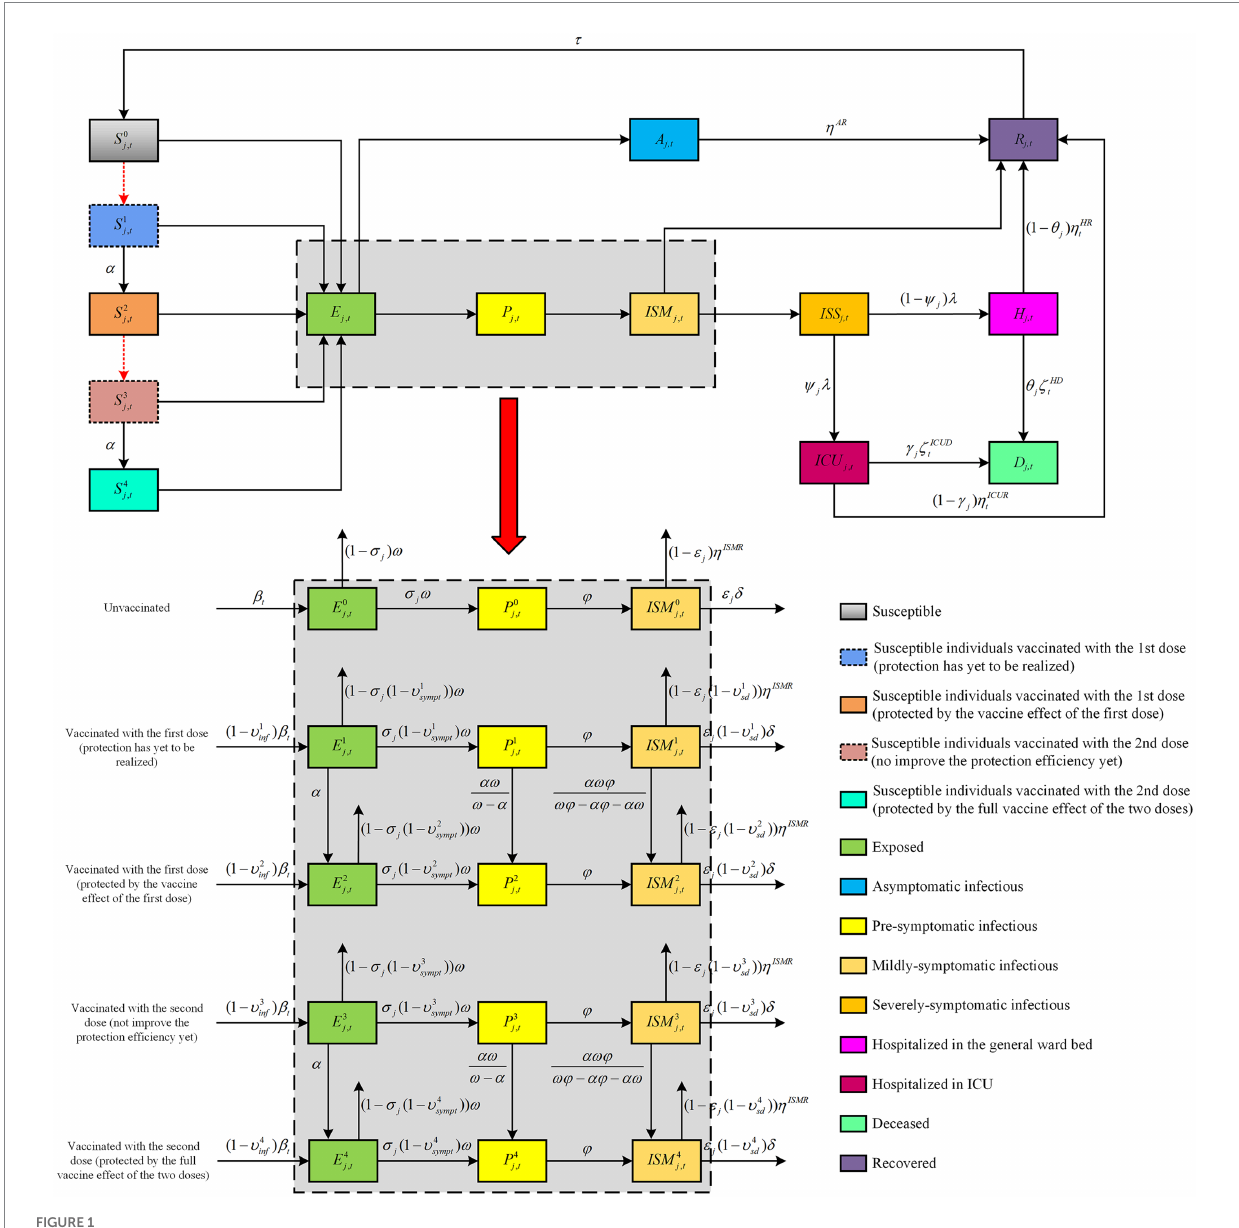
FIGURE 1 Schematic representation of the epidemiological model and transitions between